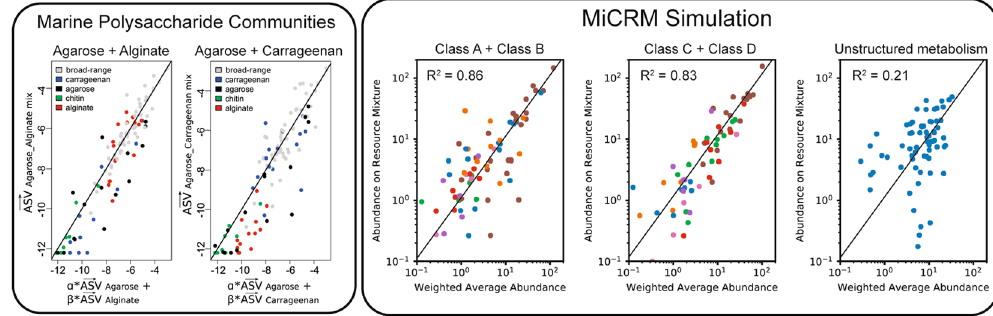
Figure 10. Modularity of community assembly. Left: In the experiments reported in 21 , synthetic beads composed of different kinds of polysaccharides, including agarose, alginate and carrageenan, were incubated with coastal seawater and colonized by the marine bacteria resident in the seawater sample. 16S rRNA amplicon profiling was performed for communities grown on beads composed of a single kind of polysaccharide, as well as mixtures of two kinds of polysaccharides. Relative abundances of amplicon sequences variants for two different mixtures (Agarose/Alginate and Agaraose/Carrageenan) are plotted versus a weighted average of the relative abundances on the pure beads. Solid lines are fits to a linear mixture model, with R 2 of 0.84 and 0.74, respectively. Right: Abundance of each species in simulated communities supplied with mixtures of two resource types, plotted against the average of the abundances for communities supplied with just one of the resource types, with the total energy supply held constant. For the first two panels, all other parameters are the same as for the human microbiome simulations of Fig. 6, except that each sample is initialized with all 5,000 species from the regional pool. Titles indicate the class labels of the two supplied resources for each scenario, and species are colored by metabolic family following Fig. 4. In the third panel, simulations were run with the same number of resources and species, but with all resources assigned to the same resource class, eliminating all metabolic and taxonomic structure. Solid lines are predictions of the additive model where the abundance in the mixture equals the average of the abundances in the single-resource condition. The R 2 score of this model is also shown in each